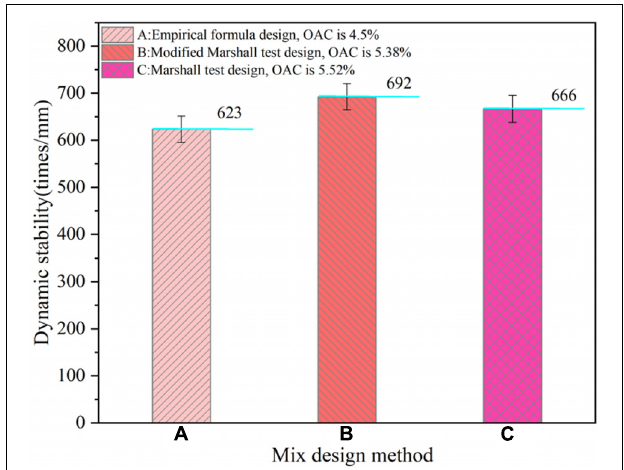
FIGURE 9 | High-temperature stability test results for